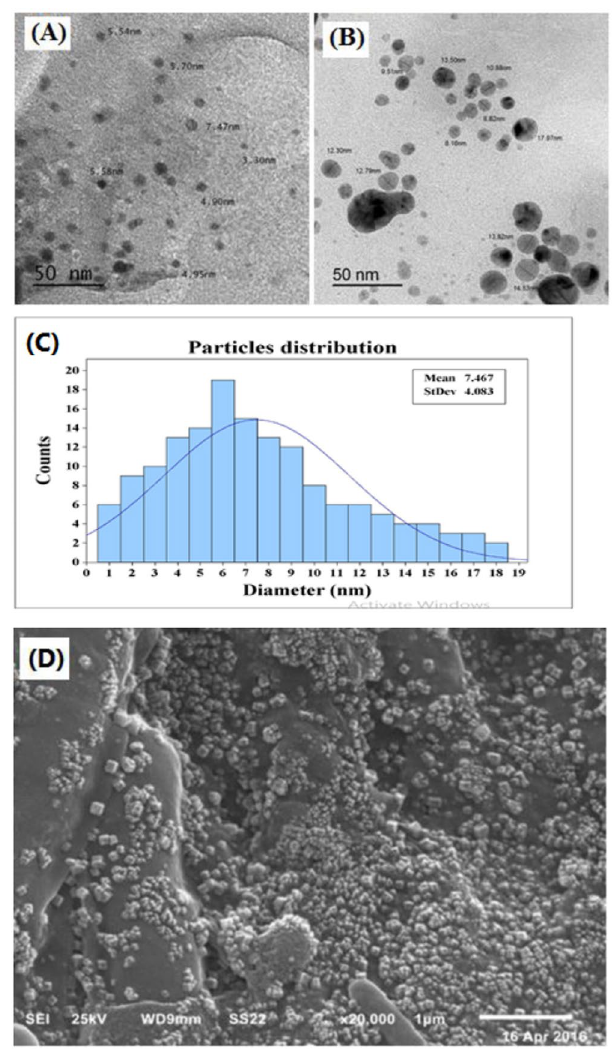
Figure 4. TEM image of O-AgNPs ( A , B ), particles size distribution ( C ) and SEM image of biosynthesized O-AgNPs ( D